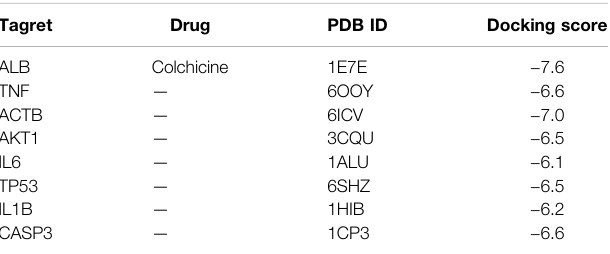
TABLE 1 | The docking scores of colchicine with key